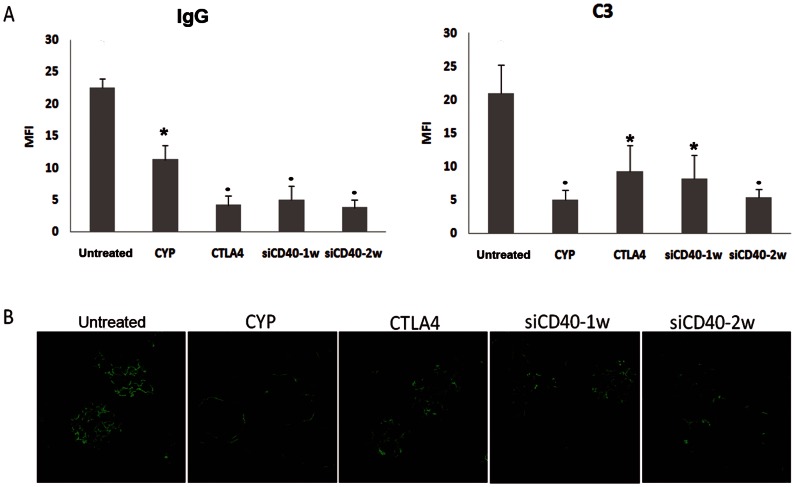
Immunohistochemical analysis for renal IgG and C3.A) Deposits of renal IgG and C3 were quantified with confocal microscopy (MFI). All treatments reduced glomerular deposits. B) Representative photomicrographs of C3 deposits (x630) for each group. Data are expressed as mean±SEM. *p<0.05 vs untreated, · p<0.01 vs untreated.